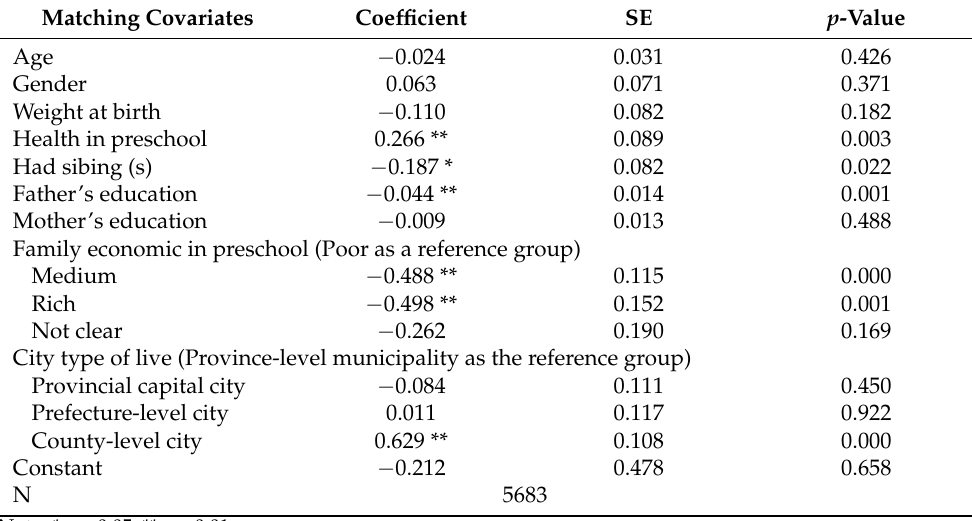
Table 4. Estimates of propensity for being left-behind experienced by urban